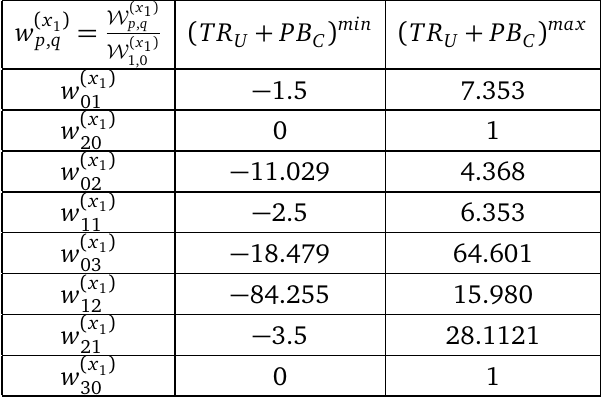
up to n = 3 in the normali- U